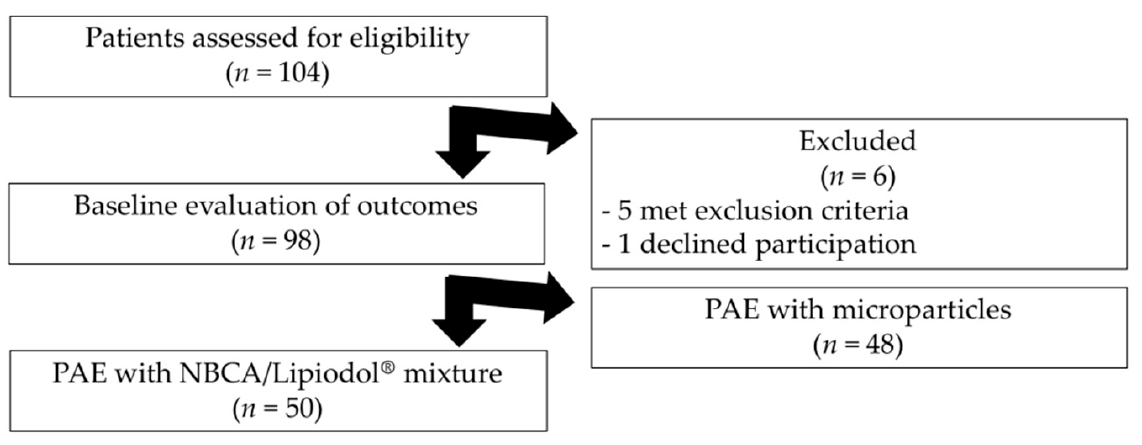
Figure 2. Flow chart of the study. PAE, prostate artery embolization; NBCA, N-butyl cyanoacrylate. Table 1. Demographics and baseline characteristics of the study population. Characteristics